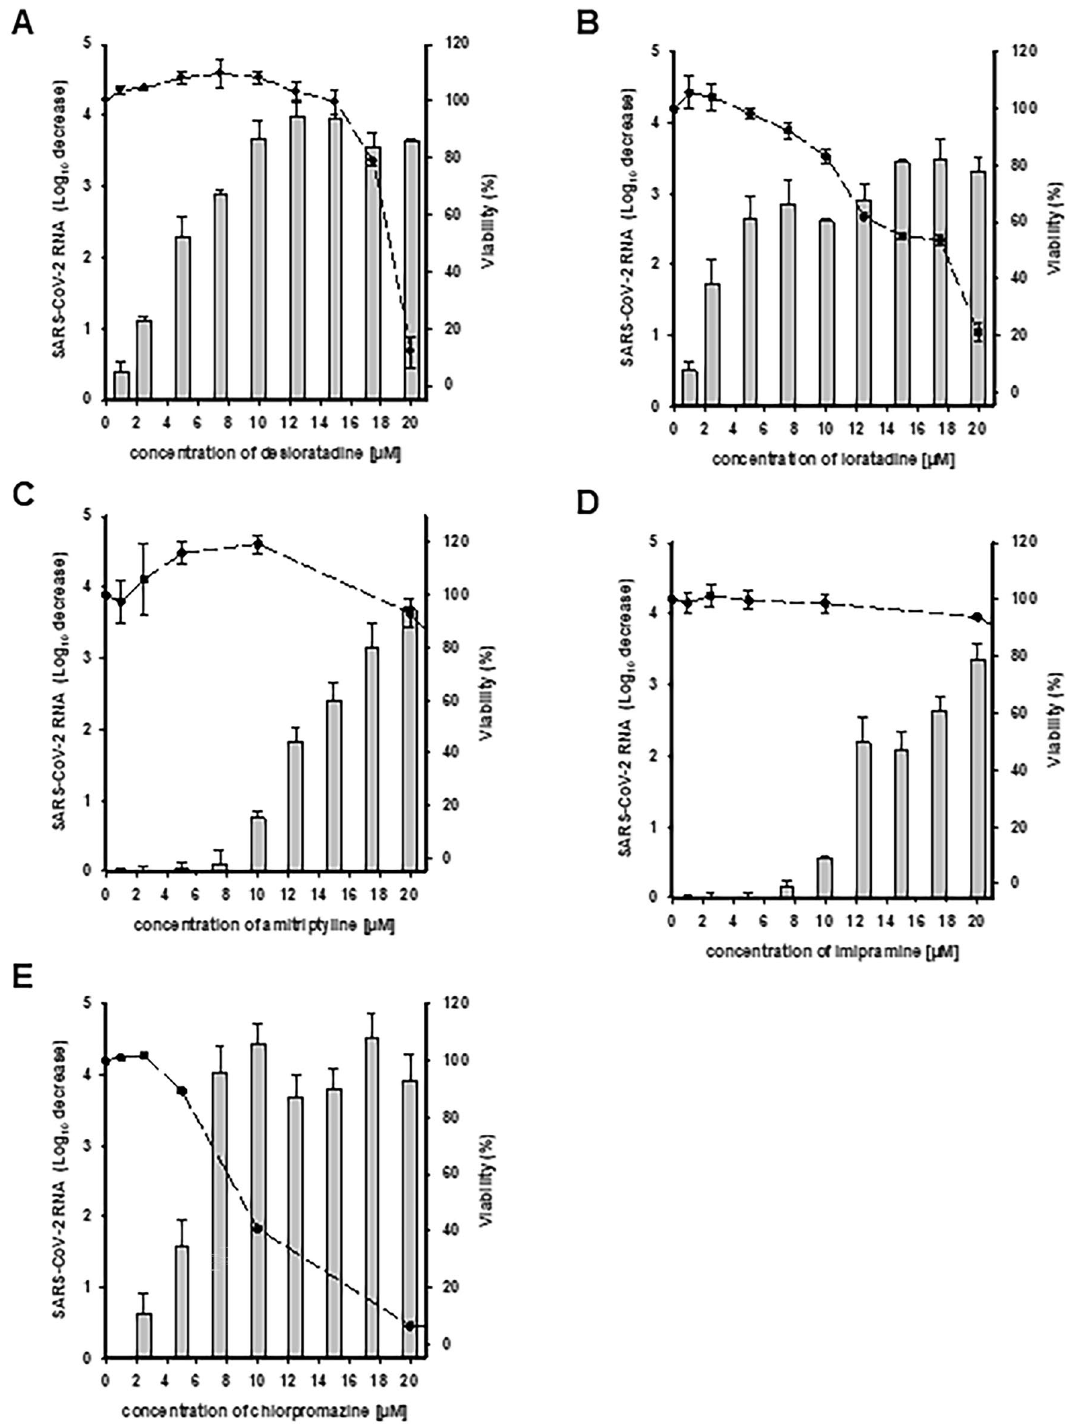
Figure 2. Assessment of the dose-dependent antiviral effectiveness of CADs against SARS-CoV-2 in Vero-E6 cells. Vero-E6 cells were infected with SARS-CoV-2 at an MOI of 0.2 in the presence of increasing concentrations of: ( A ) desloratadine, ( B ) loratadine, ( C ) amitriptyline, ( D ) imipramine and ( E ) chlorpromazine. The reduction of the extracellular production of SARS-CoV-2 RNA (grey bars) was quantified by RT-qPCR and expressed relative to the untreated control. Vero-E6 viability (black points) was monitored by MTS assay. Each bar and point represents the mean ± SD of at least two independent experiments performed in